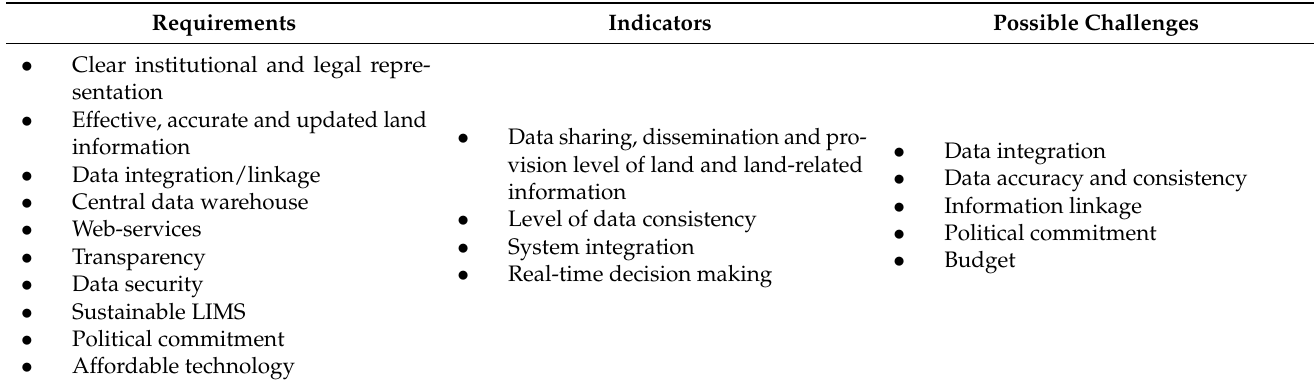
Table 7. Requirements, indicators and possible challenges towards the proposed framework.